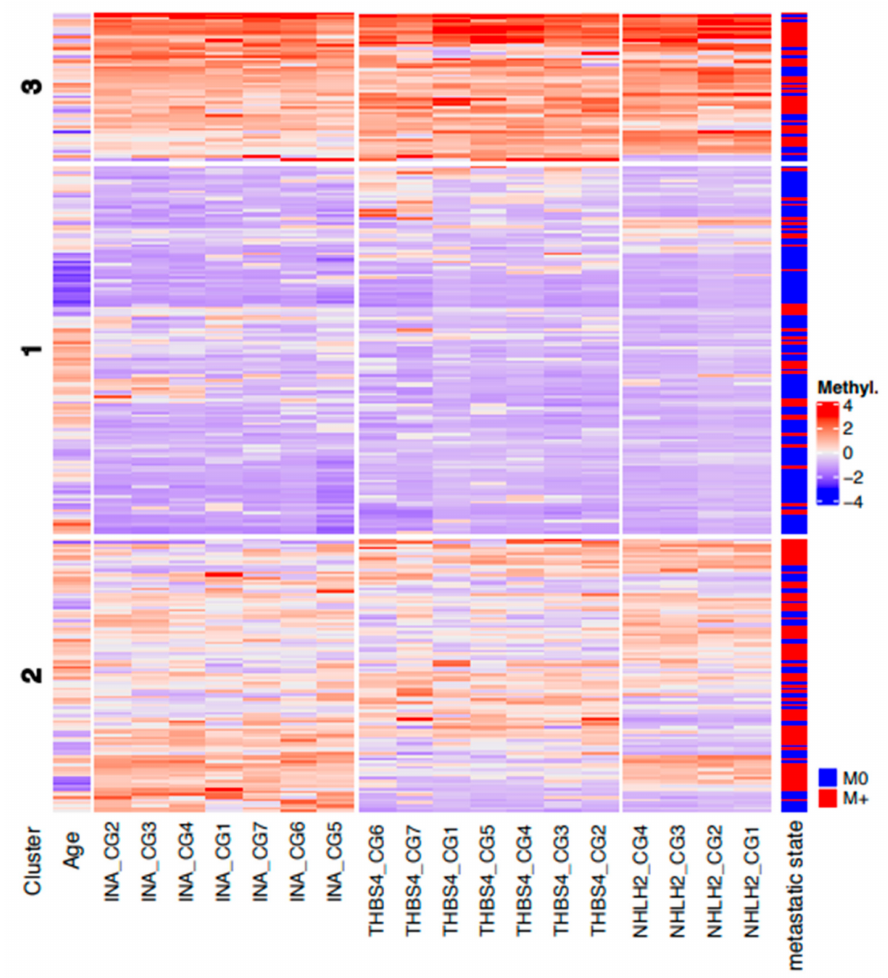
Figure 5. Heat map of unsupervised partitioning of the CpG site-specific methylation as observed in all tumor and metastatic tissue samples. Rows show patient- and sample-specific methylation data following normalization and color coding as indicated (from blue: minimum methylation to red: high methylation). The three patient clusters show most stable consensus clusters obtained by k- means partitioning. Columns present the clustered normalized ages of patients and CpG site-specific methylation data. For comparison sample corresponding metastatic disease state (M0: localized primary tumors, M+: primary metastatic tumors or metastatic tissue samples) are